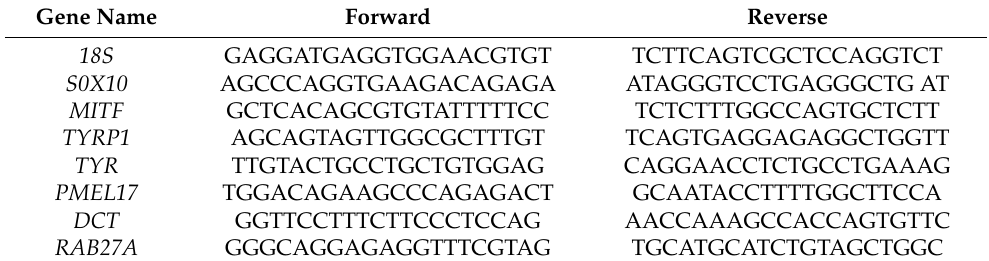
Table 2. Primers used in qPCR